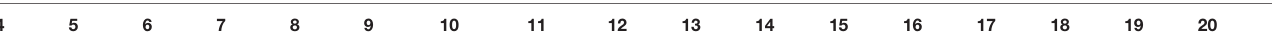
TABLE 3 | Inter-item polychoric correlation coefficients for the 21-Item GIS ( N